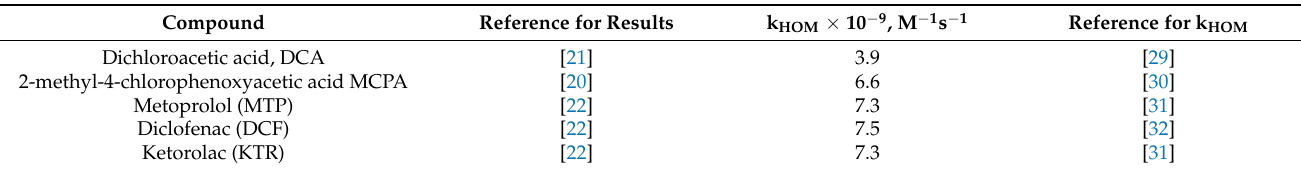
Table 1. Contaminants considered and their corresponding hydroxyl radical rate constant values. Compound Reference for